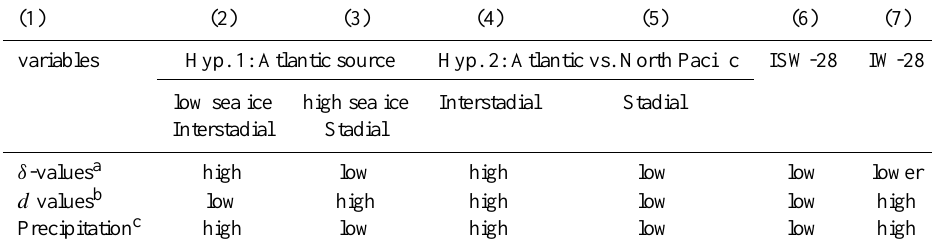
a primarily influenced by the temperature at the site location; b primarily influenced by the temperature at the moisture source